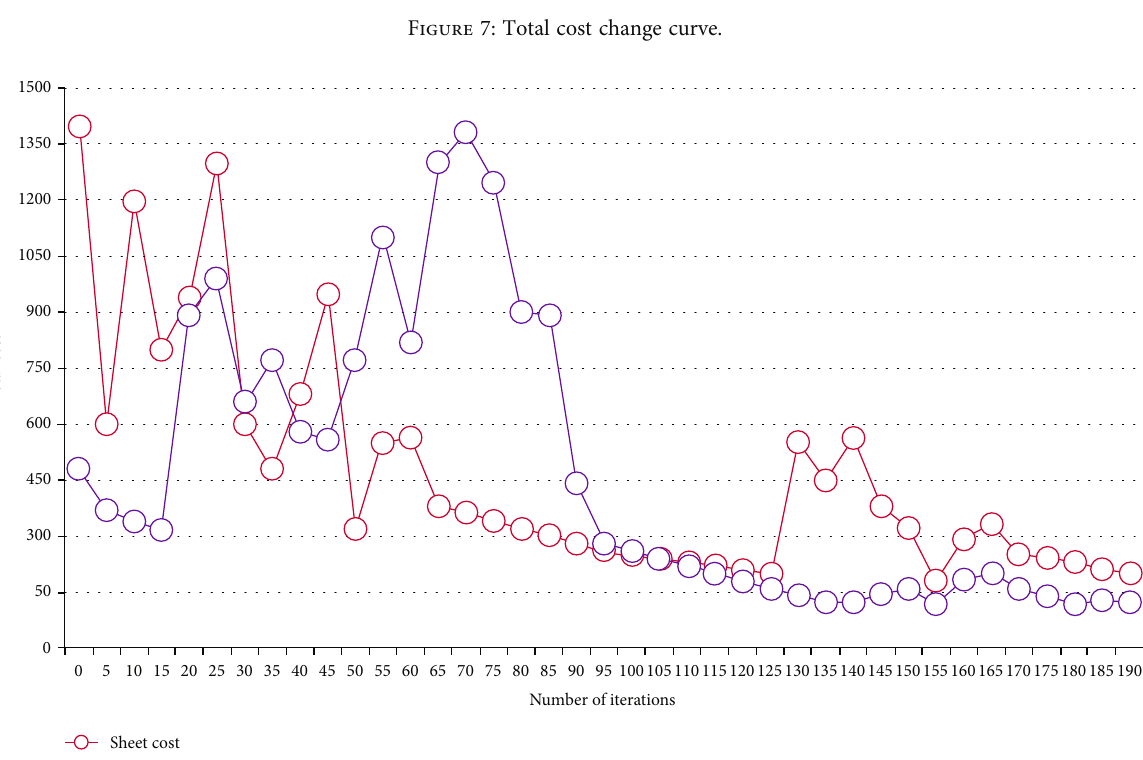
Figure 8: Subitem cost change